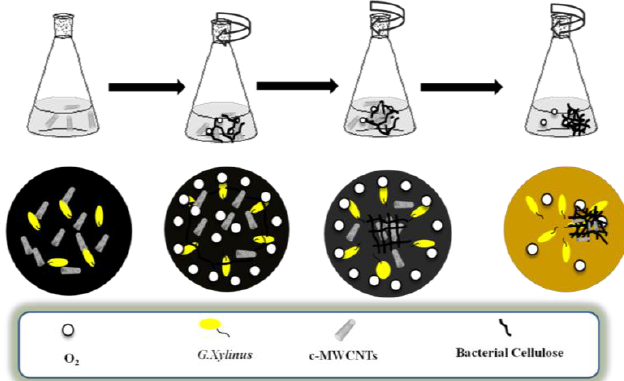
Figure 4. Schematic illustration of formation of bacterial cellulose and the integration of carbon into the 3D interconnected fibrous network of BC. the 3D interconnected fibrous network of